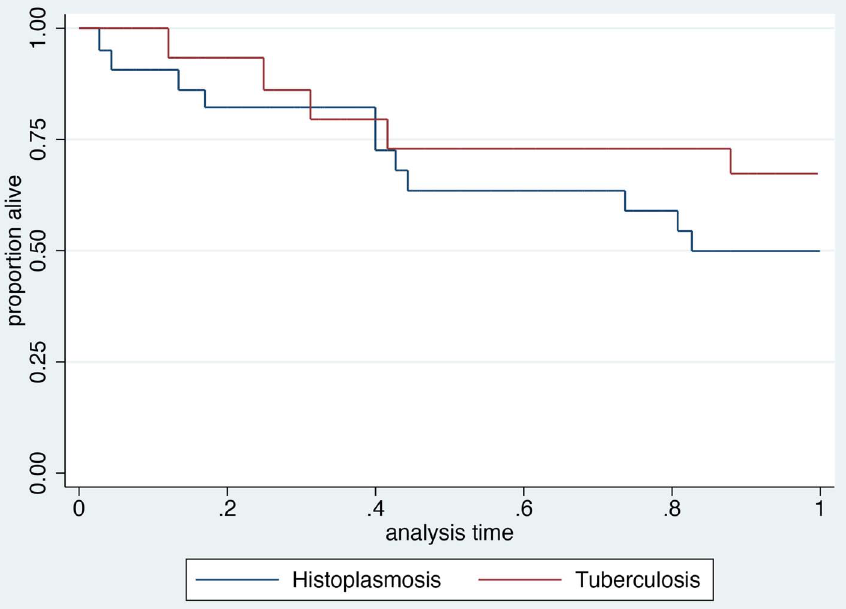
Figure 2. Shows the incidence of death during the first year afer histoplasmosis or tuberculosis among patients with CD4 counts less than